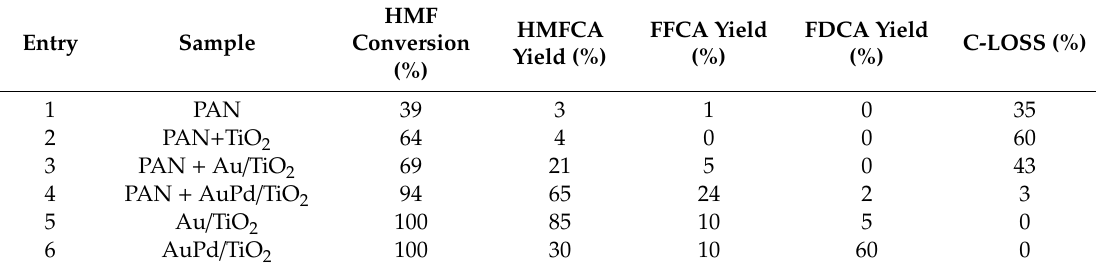
Table 1. Catalytic performances of PAN-derived materials. Reaction conditions: 4 h, 70 ◦ C, O 2